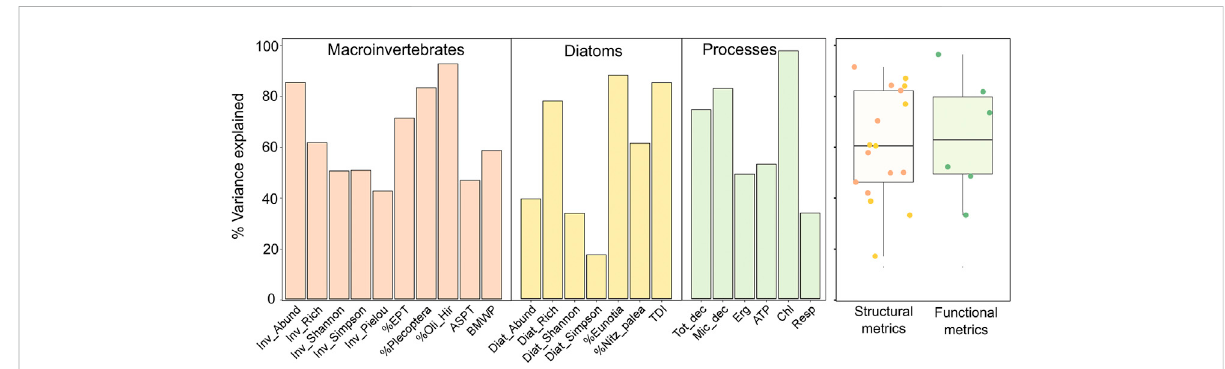
FIGURE 2 Percentage of variance explained for Macroinvertebrates, Diatoms, and Ecosystem Processes metrics models (see the metrics description in Table 2). Diat_Pielou is not shown because it was not possible to run the model. Boxplot of structural (Diatoms and Macroinvertebrates) and functional (ecosystem processes) metrics results. See all model settings and statistics in the Supplementary